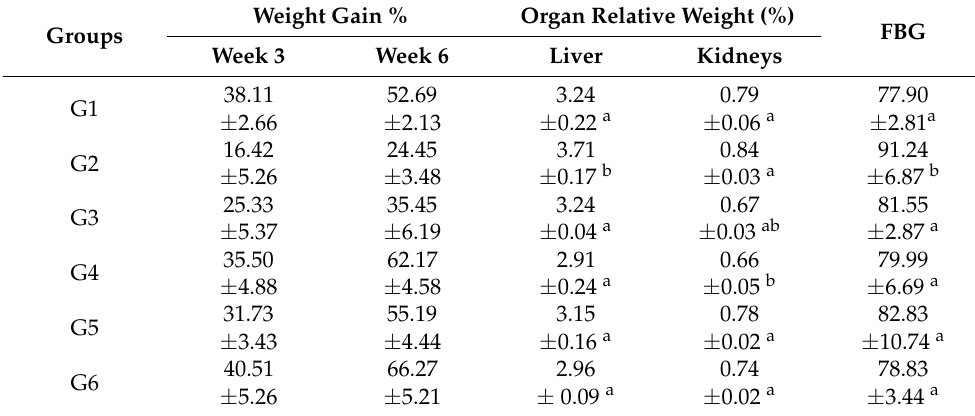
Table 4. The effect of FS and FSS extracts on weight gain %, organ weight, and FBG in CCl 4 -induced nephrotoxicity and oxidative stress in rats (mean ± SE), n = 8.